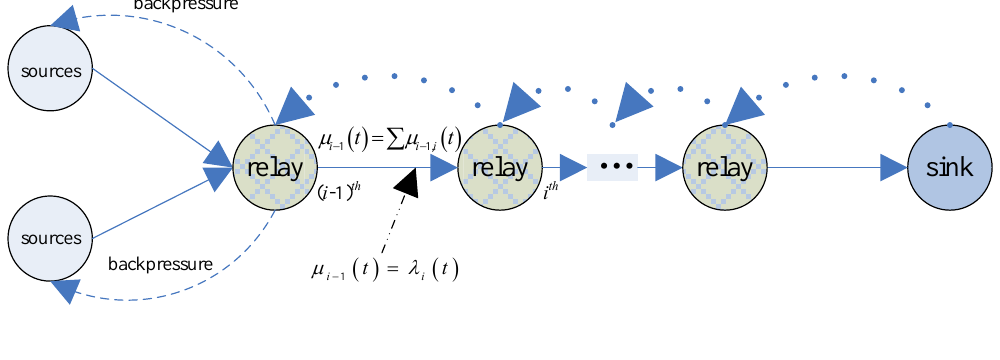
Figure 3. The relationship between inputting and outputting rate of node.